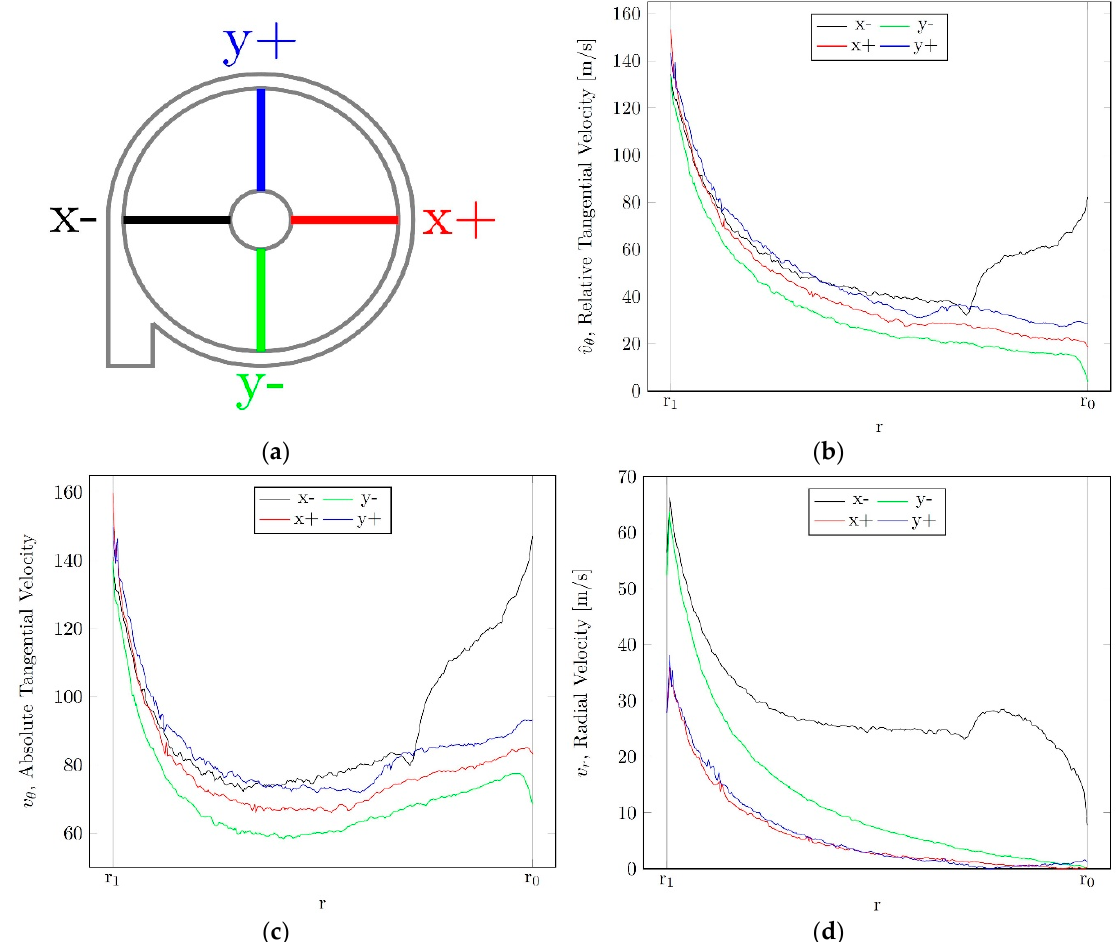
Figure 8. ( a ): Imaginary line positions inside TT along the radius. ( b ): Relative tangential velocity profile. ( c ): Absolute tangential velocity profile. ( d ): Radial velocity profile.